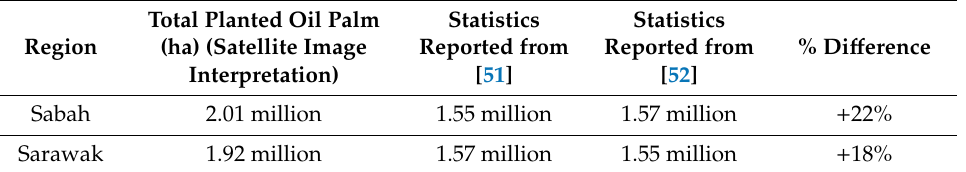
Table 12. Oil palm planted area in 2018 in Sabah and